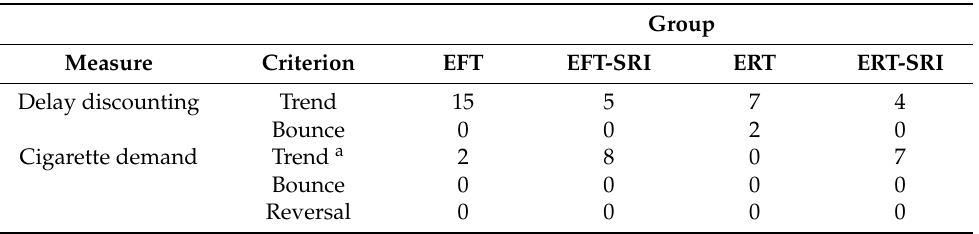
Table 2. Numbers of participants whose delay discounting and cigarette demand data were identified as nonsystematic by individual